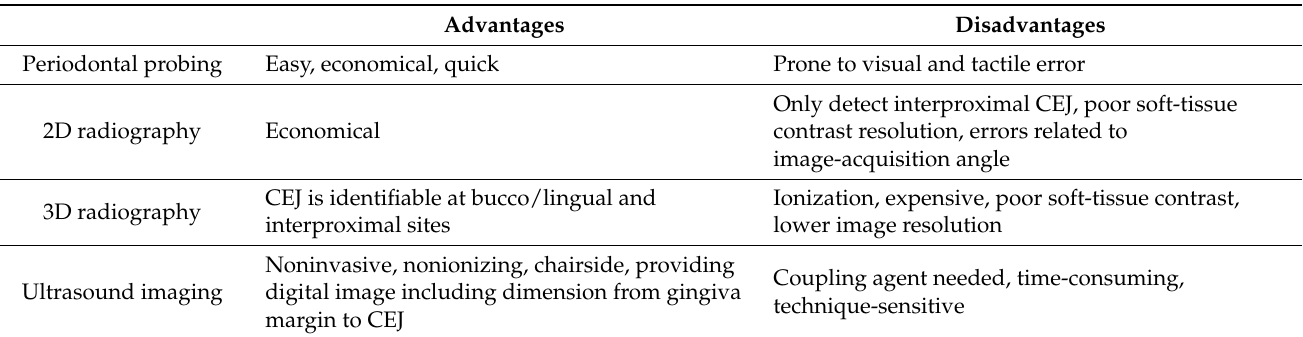
Table 2. Summary of the methods to determine negative gingival recession.